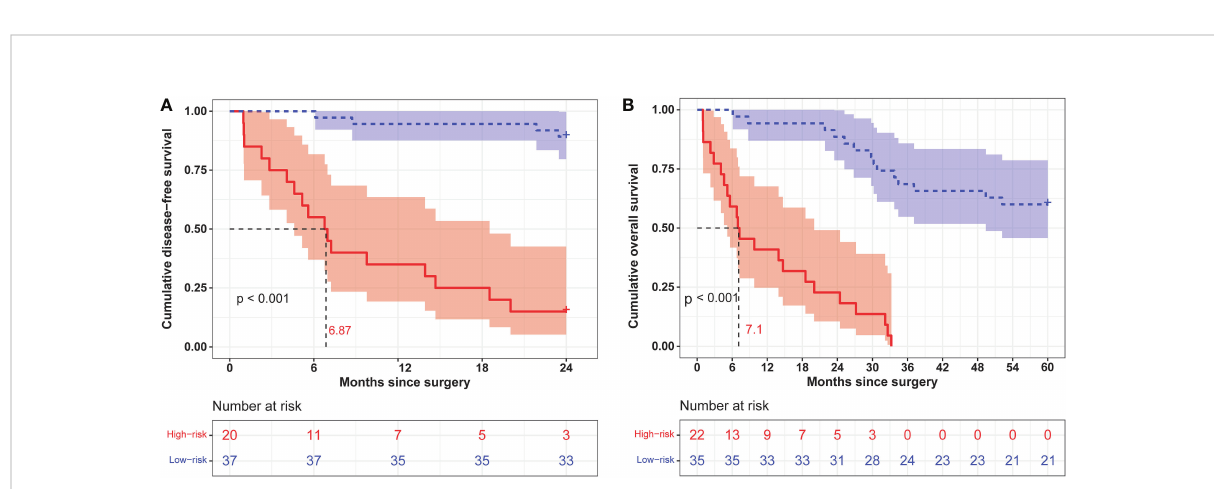
FIGURE 5 Kaplan – Meier curves of 2-year (A) and 5-year (B) disease-free survival in different risk groups classi fi ed according to nomogram